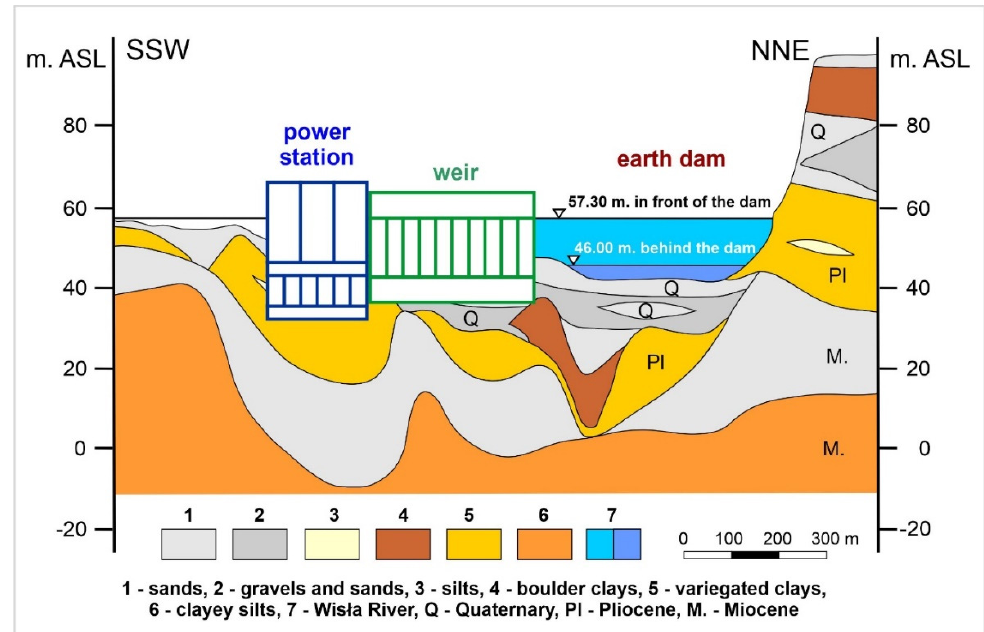
Figure 3. Geological cross section of the W ł oc ł awek water power plant.